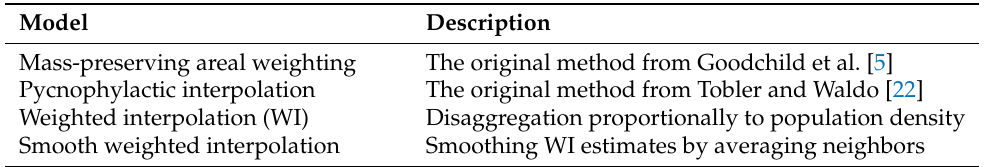
Table 2. The different heuristics tested for producing the initial